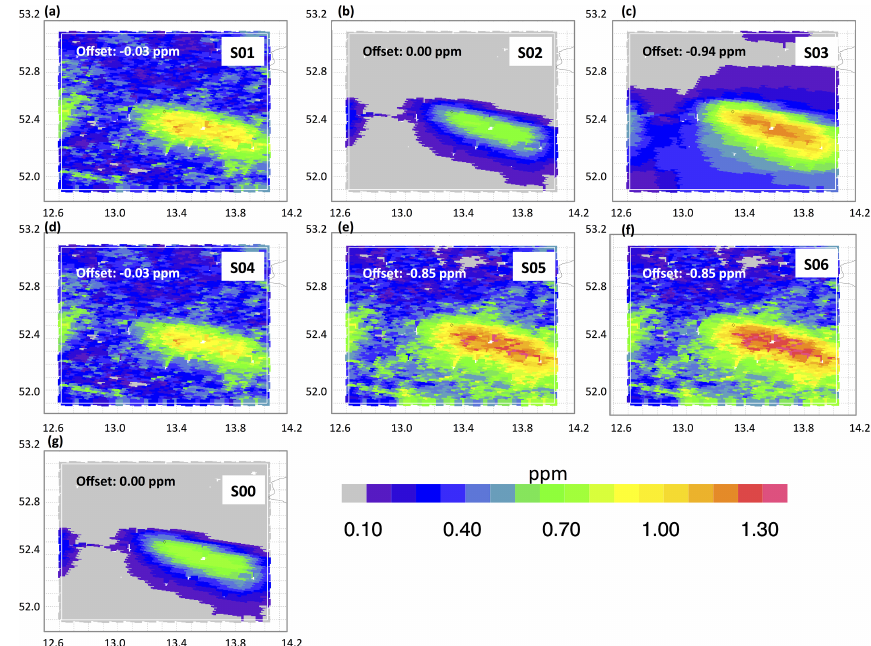
Figure 8. Observed anthropogenic XCO 2 enhancement over the target region during a CarbonSat overpass on 24 June 2008 (swath width: 500km). Different panels show anthropogenic XCO 2 enhancement, while considering XCO 2 systematic errors for different scenarios as shown in Fig. 8. The true XCO 2 (fossil fuel (FF)) enhancement (i.e. without any uncertainties) is given in the bottom panel (g) for comparison. Note that an offset, labelled inside each panel, is subtracted from the anthropogenic XCO 2 enhancement to better visualize the details (for the figure only). All units areppm.